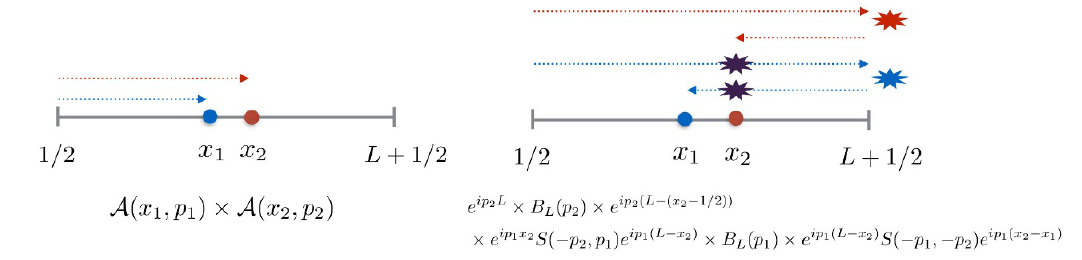
Figure 5 . For the (cid:12)rst term tions x 1 ; 2 independently without any nontrivial factors. On the other hand, the term S ( p 2 ; p 1 ) S ( p 2 ; p 1 ) e 2 i ( p 1 + p 2 ) L B L ( p 1 ) B L ( p 2 ) (cid:0)